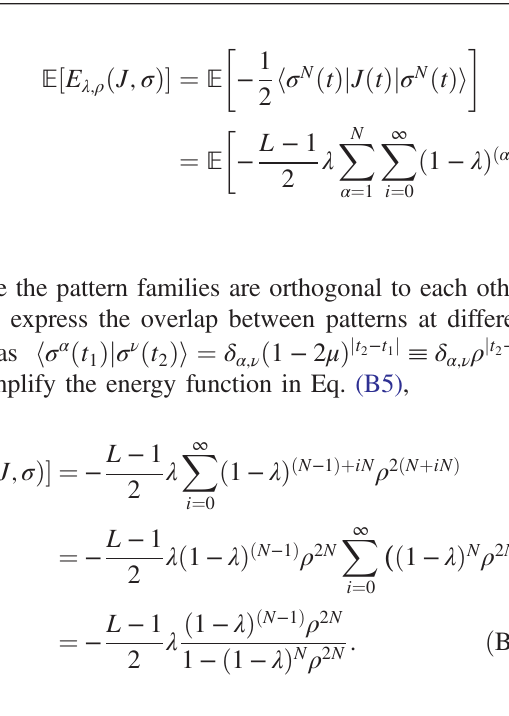
ffiffiffiffiffiffiffiffiffiffiffiffiffiffiffiffiffiffiffiffiffiffiffi p 8 μ = ð N − 1 Þ